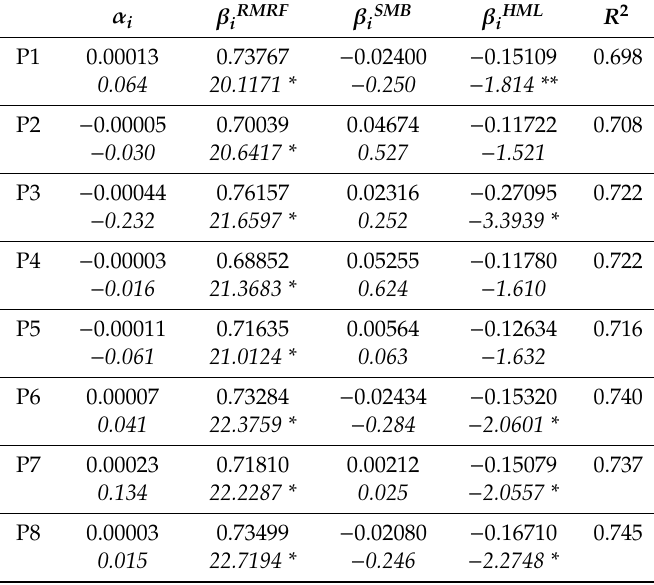
Table A2. Time-series regression results for the three-factor model 1